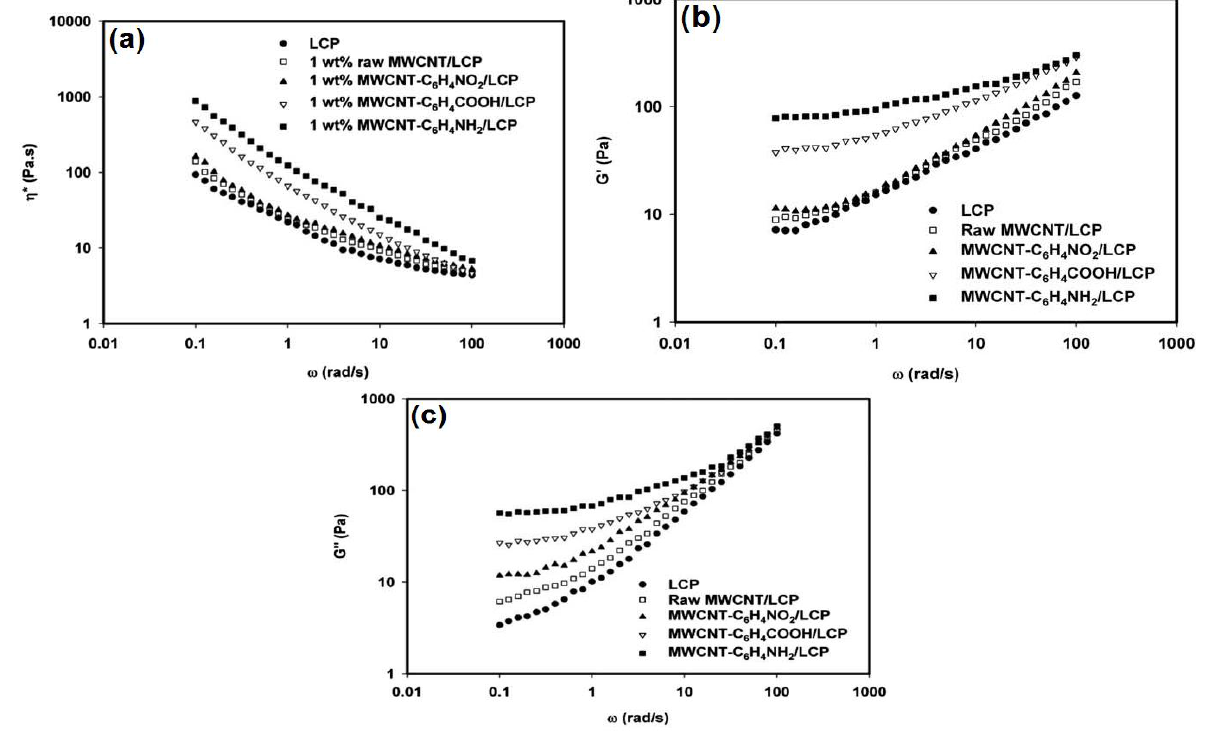
Figure 4. ( a ) Complex viscosity (η*) versus angular frequency (ω), ( b ) storage modulus (G') versus angular frequency (ω), and ( c ) loss modulus (G'') versus angular frequency (ω) for MWCNT/TLCP composites at 300 °C [55]. Reproduced by permission of The Royal Society of Chemistry.